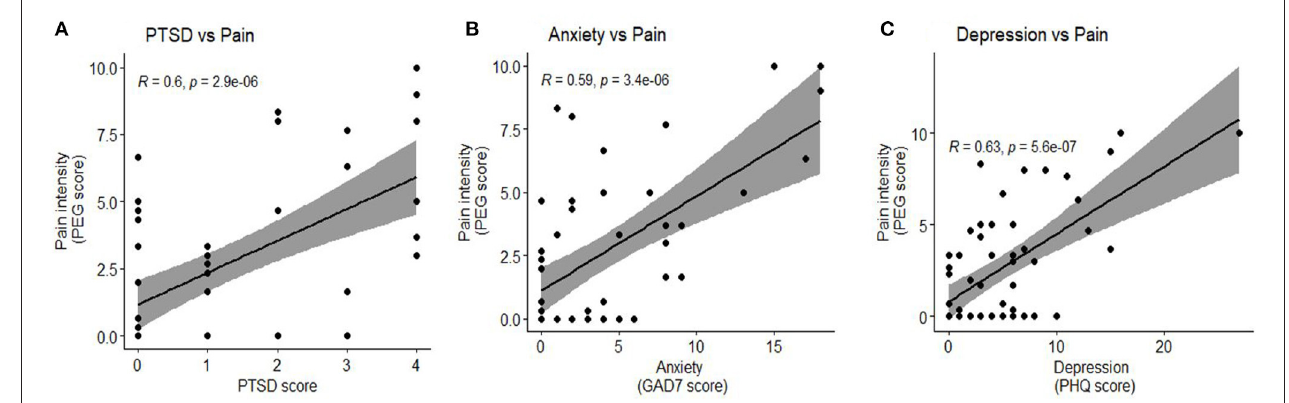
FIGURE 1 | Association of Pain with PTSD, anxiety and depression. (A) Pain intensity had a significant positive correlation with PTSD score ( r = 0.6, p < 0.01) (B) Pain intensity had a significant positive correlation with anxiety, quantified by the GAD7 score ( r = 0.59, p < 0.01) (C) Pain intensity had a significant positive correlation with depression, quantified by the PHQ score ( r = 0.63, p < 0.01).